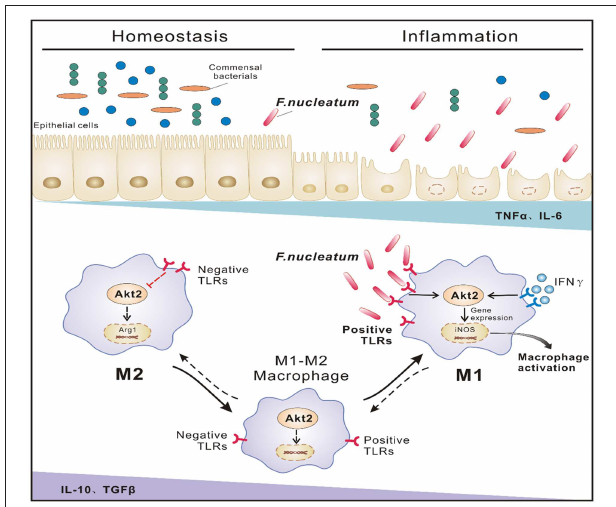
FIGURE 7 | Proposed model of F. nucleatum -induced M1 macrophage polarization and proinflammatory cytokine production via the AKT2 pathway in the context of UC. In the inflammatory state of UC, increased F. nucleatum induces mononuclear macrophage infiltration by activating AKT2 signaling and differentiation into iNOS-positive M1 cells, secreting a large amount of inflammatory factor TNF- α and IFN- γ , etc., which in turn damages the intestinal mucosal epithelial barrier and increases intestinal permeability and bacterial translocation, leading to increased inflammation and progression of the